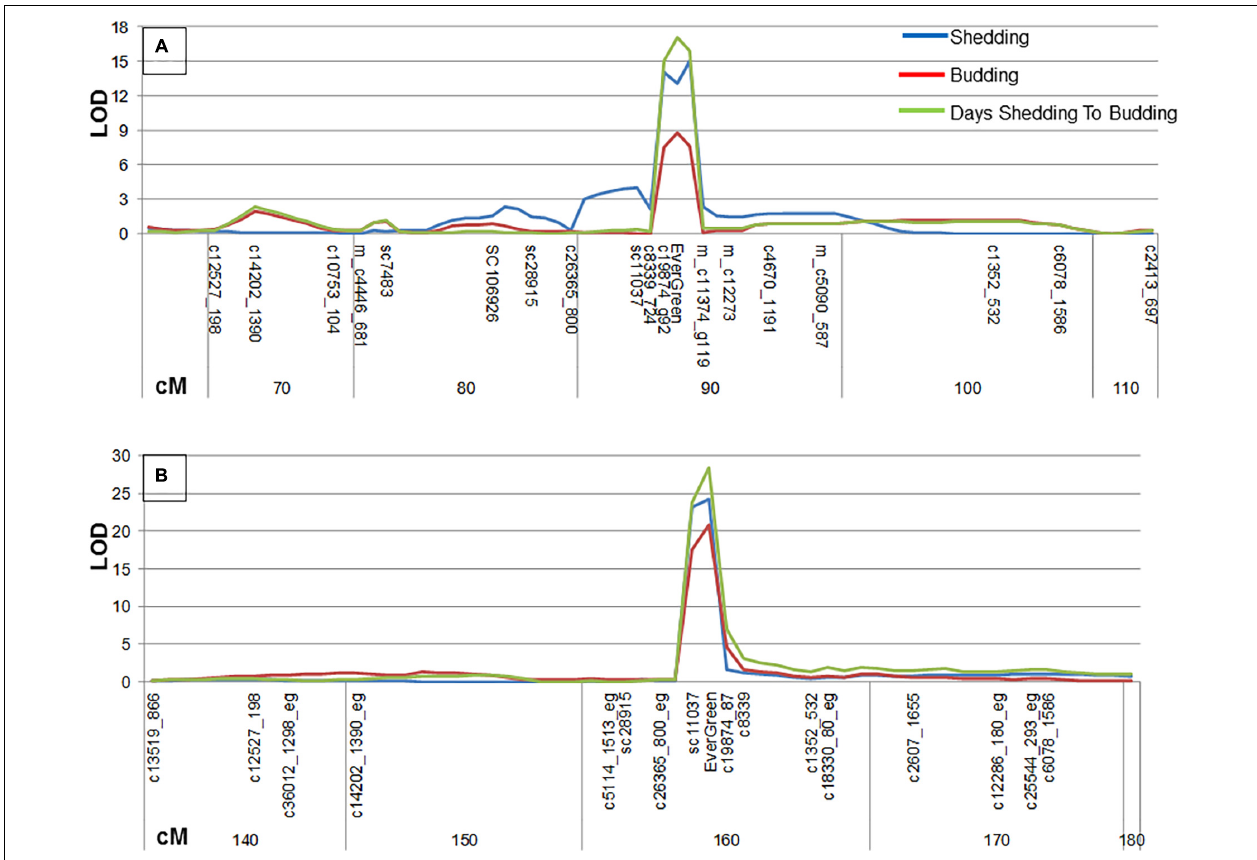
FIGURE 4 | Three evergreen related traits were subjected to QTL analysis and mapped to LG3. MQM analysis for three traits: shedding (Blue, days from the date leaves were yellowing to November 1st), budding (Orange, days from the date of budding to November 1st), and days from shedding to budding (green). The analysis was done for ‘P.G.160-61 × P.G.100-1’ F2 population in 2011–2012 (A) and for ‘Nana × Black’ F2 population in 2012–1013 (B) . The x axis represents the markers as they ordered along the LG3 and cM